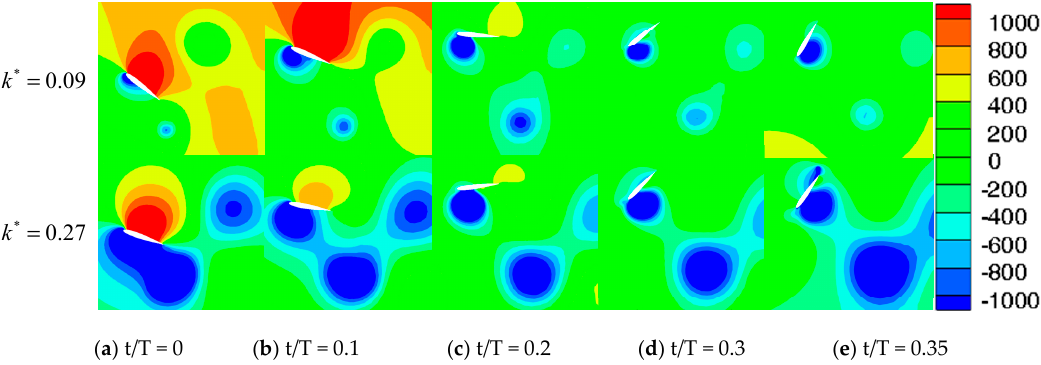
Figure 13. Instantaneous vorticity contours at t/T = 0 − 0.35 for different spring stiffnesses ( 𝑘 ∗ = 0.09, 𝑘 ∗ = 0.27 , ( a ) t/T = 0, ( b ) t/T = 0.1, ( c ) t/T = 0.2, ( d ) t/T = 0.3, ( e ) t/T = 0.35).